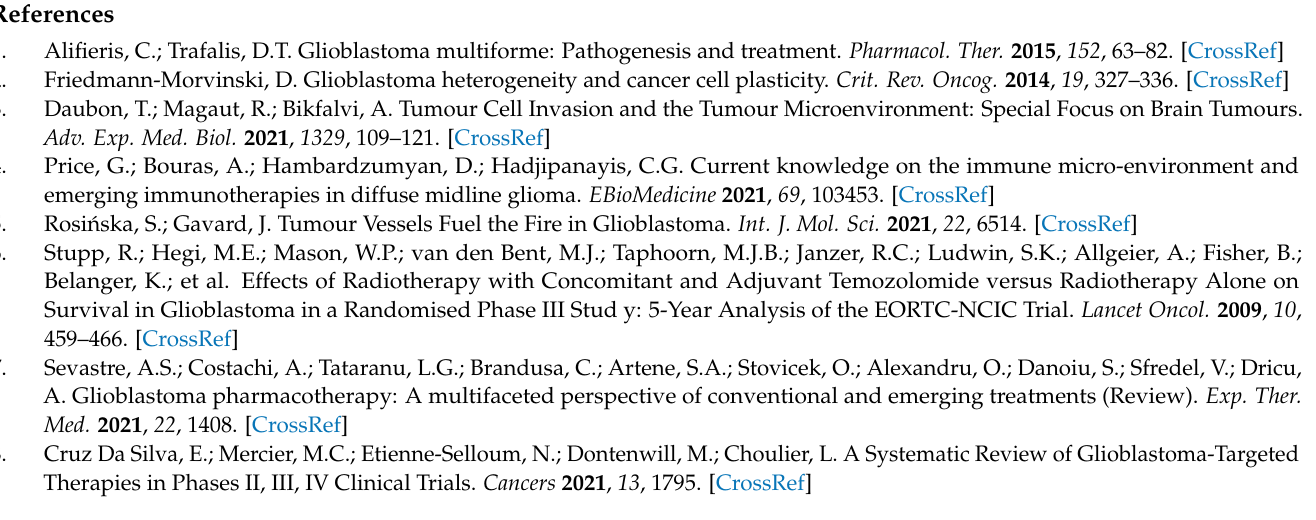
Western blots shown in Figure 1C; Figure S3: Uncropped Western blots shown in Figure 2A,B; Figure S4: Uncropped Western blots shown in Figure 4D; Figure S5: ATX-101 increases the levels of γ H2AX induced by RT; Figure S6: Uncropped western blots shown in Figure 6D,F; Table S1: Characterization of GBM cell lines used; Table S2: Weights of mice and tumours in the subcutaneous xenograft model; Table S3: Radio-sensitization of ATX-101 on U87MG and T98G subcutaneous xenografts; Table S4: Statistical analyses for disease-free survival (DFS) and overall survival OS (A) and HR ratios (B) for animals treated with ATX-101 with or without RT for the orthotopic brain tumour model using luciferase tagged U87MG cells; Table S5: Statistical analyses for DFS and OS (A) and HR ratios (B) for animals treated with ATX-101 with or without RT for the orthotopic brain tumour model using luciferase tagged GSGs-5